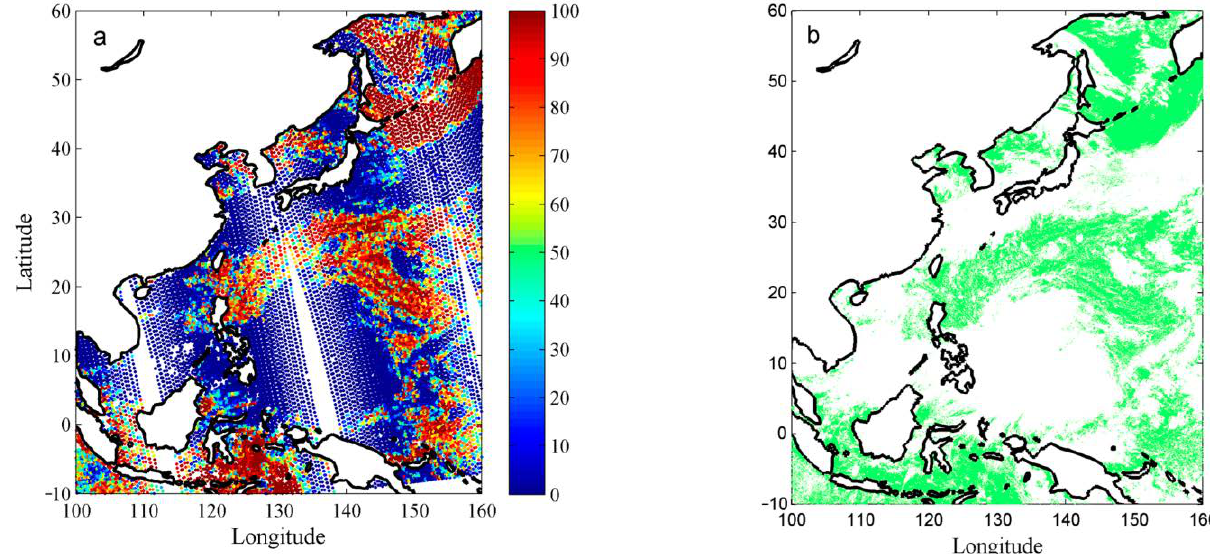
Figure 6. The spatial distribution of the ( a ) clear fractions within HIRAS FOVs, and the ( b ) MERSI-II cloud mask products on 12 September 2018. Green in the right-hand panel represents